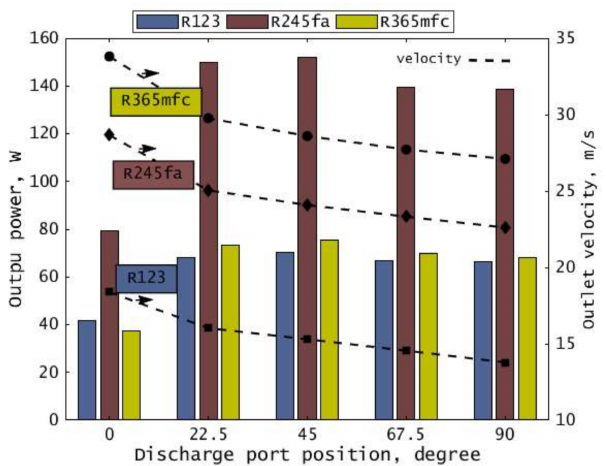
Figure 12. Output power and outlet velocity for different working fluids and different discharge port positions.